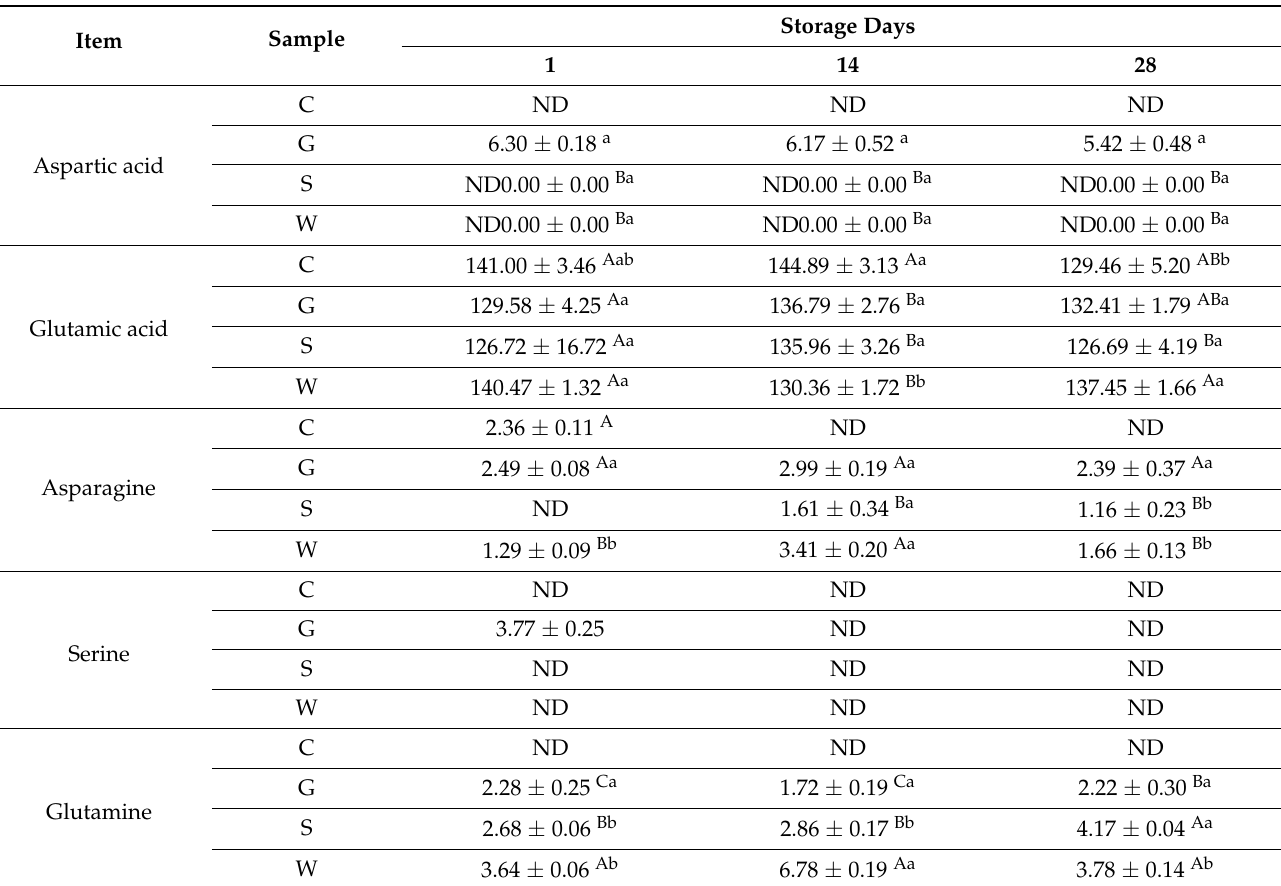
Table 3. Concentration of amino acids (mg/100 g) of probiotic whey beverages enriched with kiwi